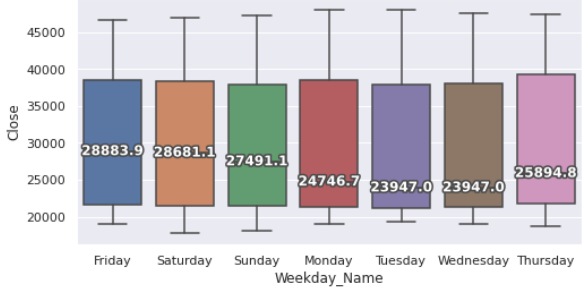
Figure 3. Average price increment ranges by